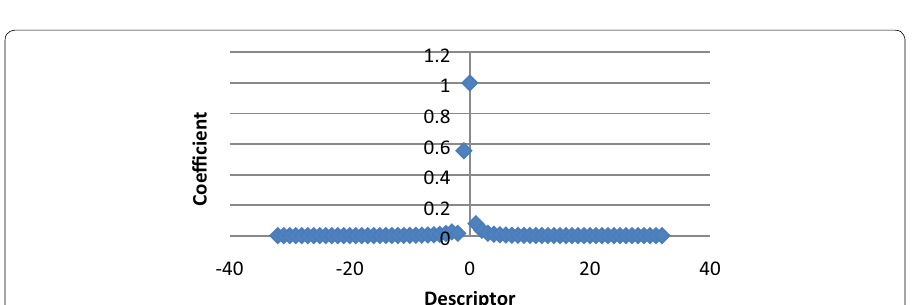
Fig. 11 Descriptor magnitude for Matmata calcareous